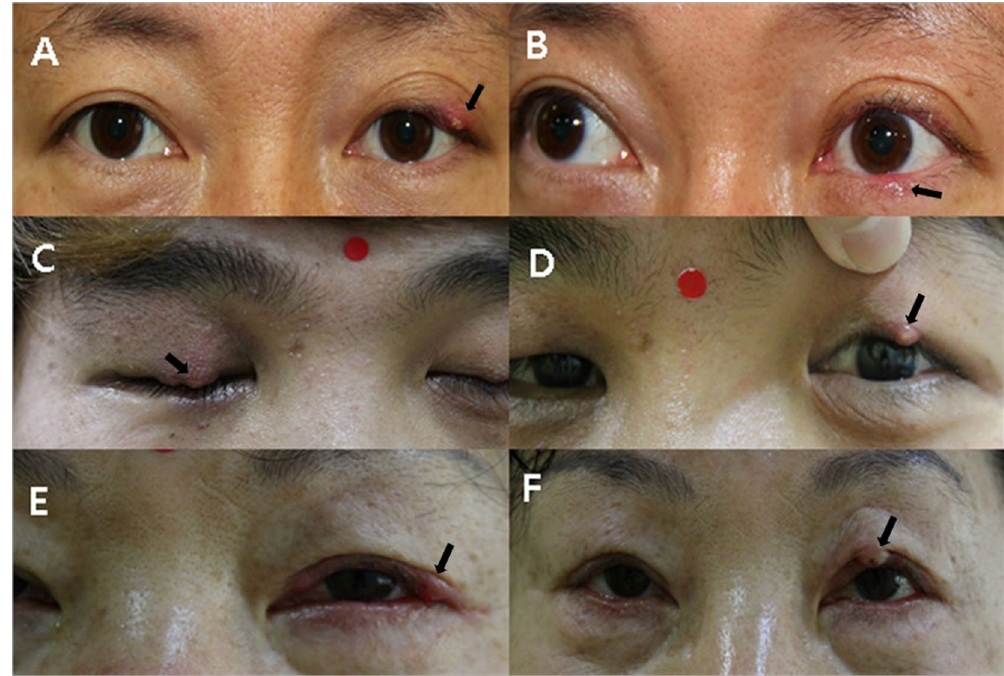
Figure 1. Patient photographs of Demodex -associated recurrent hordeola. A 54-year-old man ( A , B ), 21-year- old man ( C , D ), and 63-year-old-woman ( E , F ) demonstrate external hordeola (arrows), which recurred after a short period of time following incision and curettage. All of these patients had Demodex mites on the cilia surrounding the